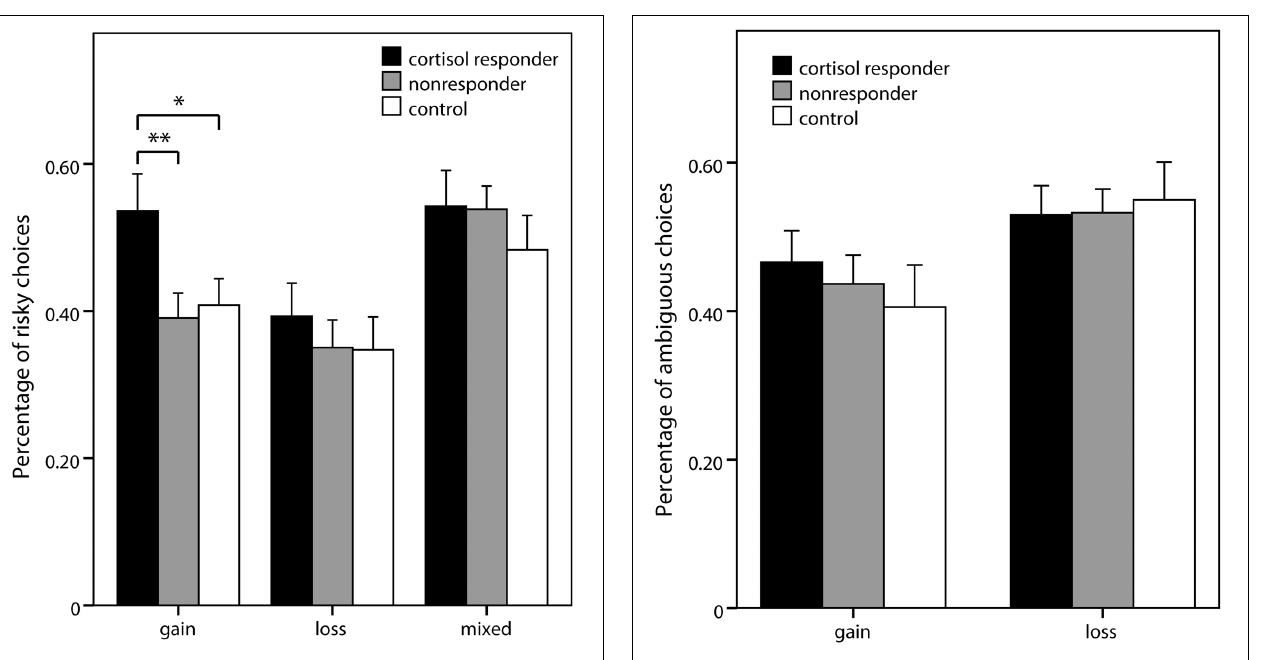
FIGURE 4 | Risky choices in the decision task. Percentage ( ± s.e.m.) of choices of the risky option (vs. sure amounts) in the three domains of the risk part of the decision making task. Simple contrasts comparing cortisol responders to nonresponders and controls were used to follow up significant main effects ( ∗ p < 0 . 05, ∗∗ p < 0 . 01).